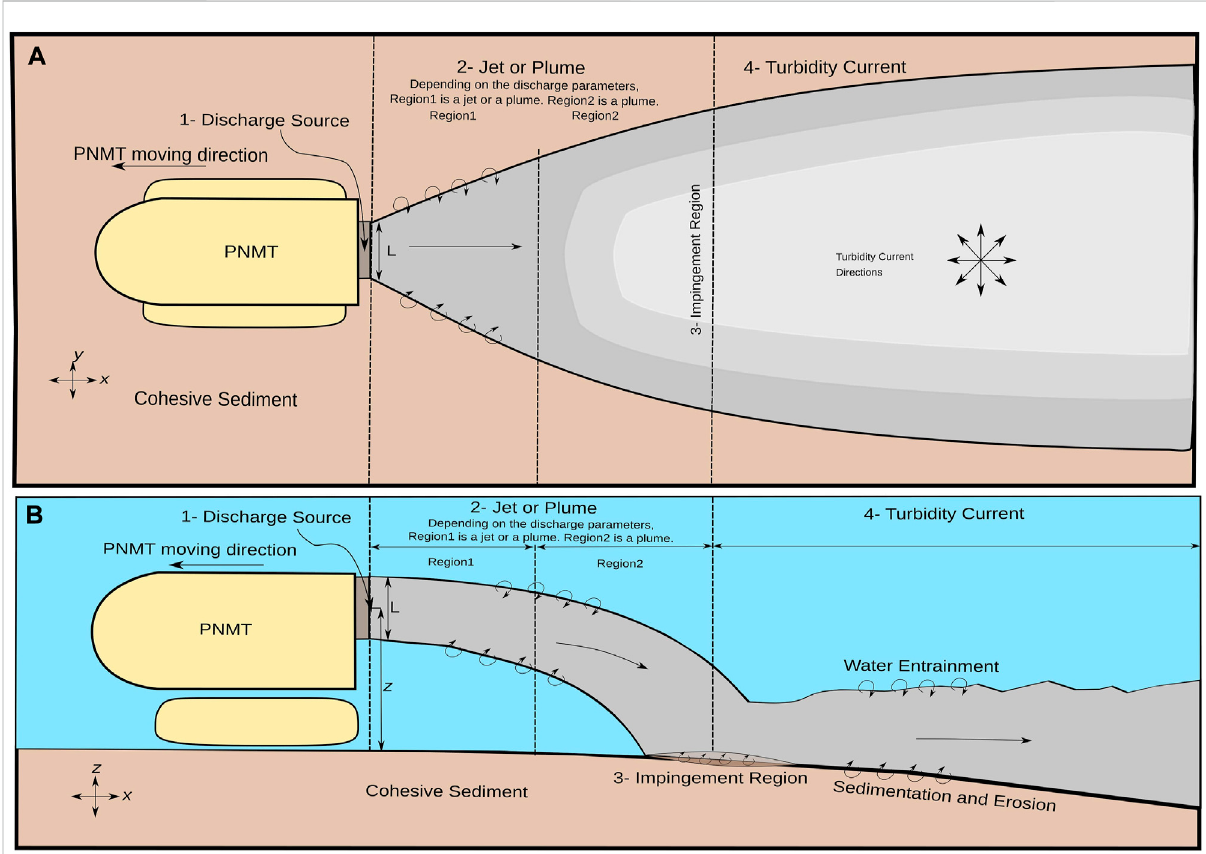
FIGURE 1 Schematic representation of how the sediment-water mixture discharged from a PNMT evolves (near fi eld area). (A) Top view of the discharge process from a polymetallic nodule mining tool (PNMT) (Elerian et al., 2022) (B) Right-side view of the discharge process from a PNMT (Elerian et al.,